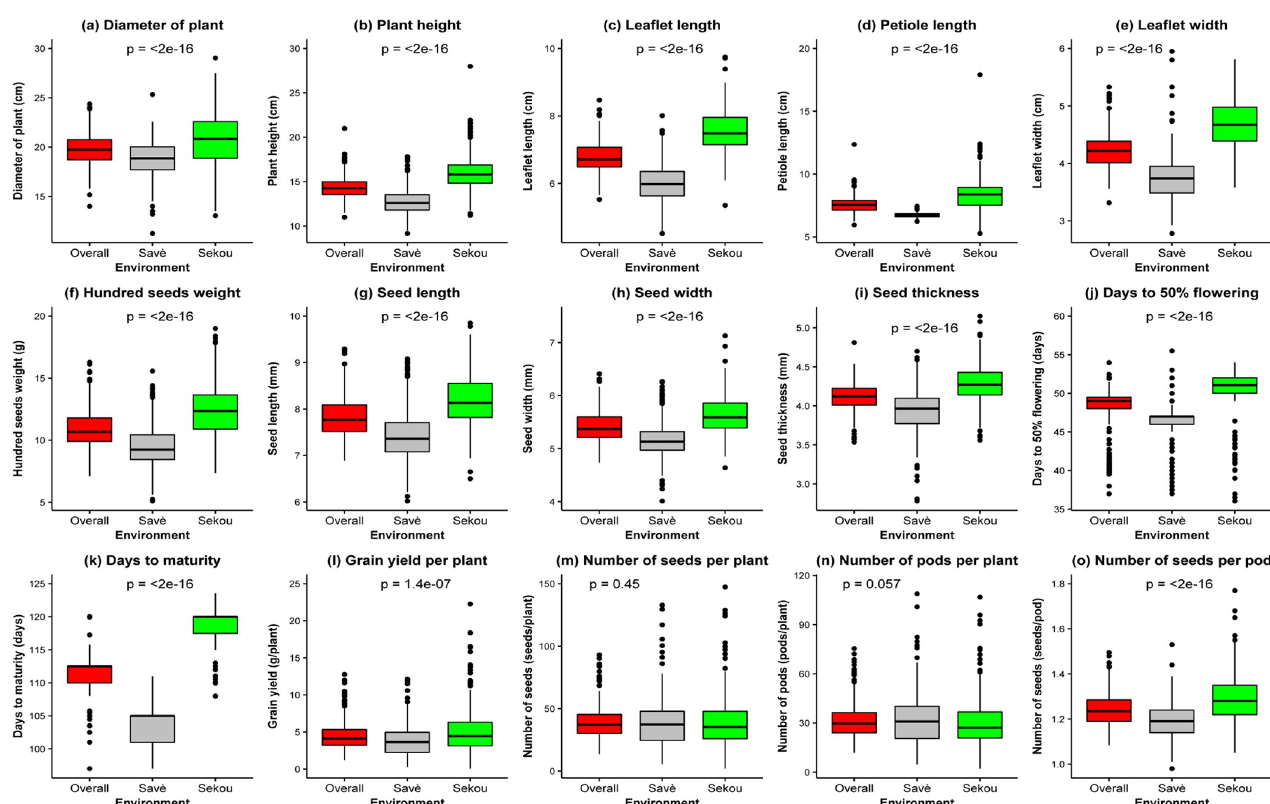
Fig 1. Variation of the 15 morphological traits across environments. was also highly significant for most traits except leaflet width, seed thickness, days to maturity and number of seeds per pod (Table 3). Average performances were lower at Sav è than Se´kou for all morphological traits (Fig 1). The coefficients of variation (CVs) and broad sense heritability estimates across environments for the 15 morphological traits are shown in Table 4. The coefficients of variation were < 20% for most traits including the diameter of the plant, plant height, leaflet length, leaflet width, petiole length, 100 seeds weight, seed length, seed width, seed thickness, and the number of seeds per pod. In contrast, higher coefficients of variation were obtained for grain yield per plant (42.2%), the number of seeds per plant (36.3%) and the number of pods per plant (34.9%), revealing that there was a high variability for those traits across environments (Table 4). Moreover, the broad sense heritability estimates were high for 100 seeds weight (0.61), days to 50% flowering (0.86), days to maturity (0.87), grain yield per plant (0.53), number of seeds per plant (0.55) and number of seeds per pod (0.52) (Table 4). Furthermore, the Pearson correlation analysis revealed highly significant (p < 0.001) positive correlations of grain yield per plant with the yield components, 100 seed weight, number of seeds per plant, number of seeds per pod, and number of pods per plant at Se´kou, Sav è and across environments (Table 5). In addition, there were significant negative correlations between grain yield per plant, days to 50% flowering and days to maturity for all environments. Moreover, a significant positive correlation was detected between grain yield per plant and seed thickness at Sav è (Table 5). GRY was poorly correlated to leaf morphological traits.